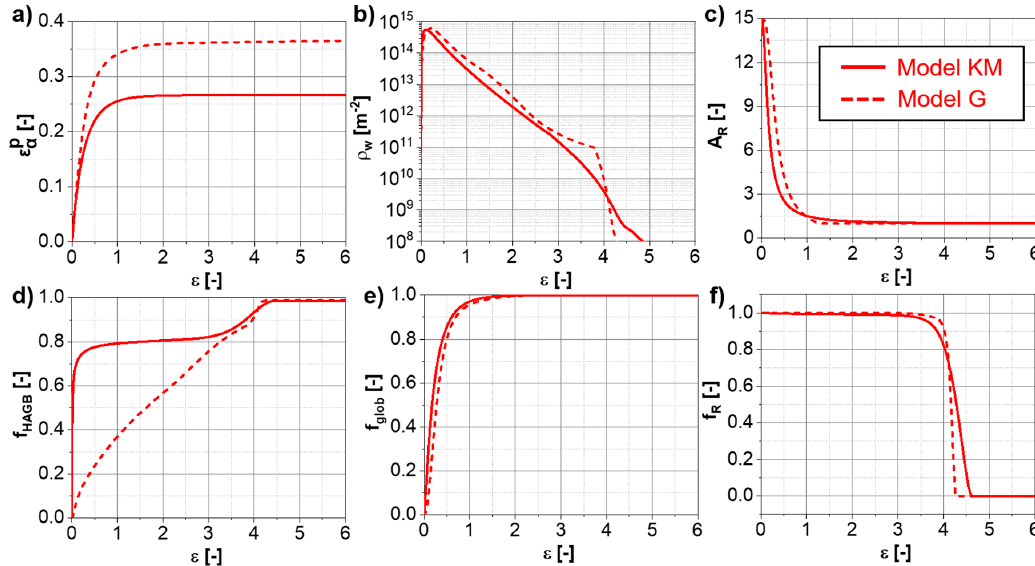
Figure 8. Evolutions of the α -phase for the Ti-17 deformed at 810 °C and 0.001 s − 1 predicted up to large strains using “Model KM” and “Model G”: ( a ) plastic deformation, ( b ) wall dislocation density, ( c ) α - aspect ratio, ( d ) fraction of HAGB, ( e ) α -globularized fraction, ( f ) fraction of Rayleigh distribution.